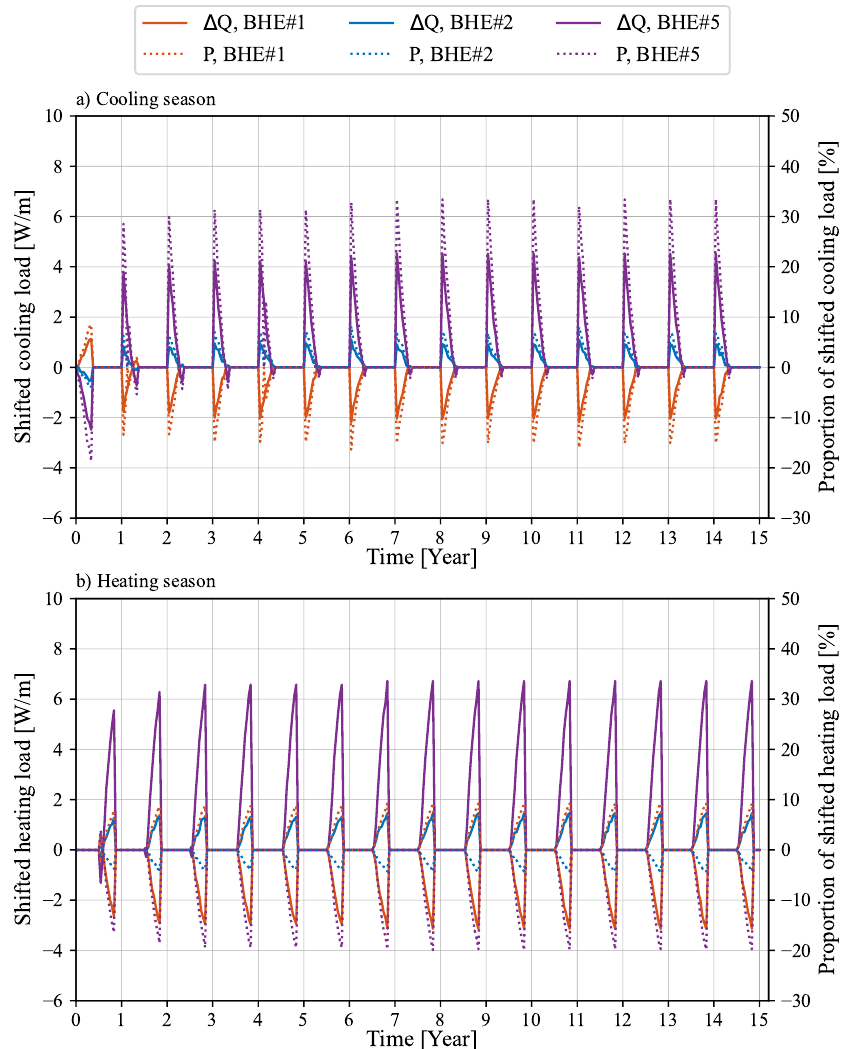
Figure 11. Evolution and the proportion of the shifted load in the ( a ) cooling season and ( b ) heating season over 15